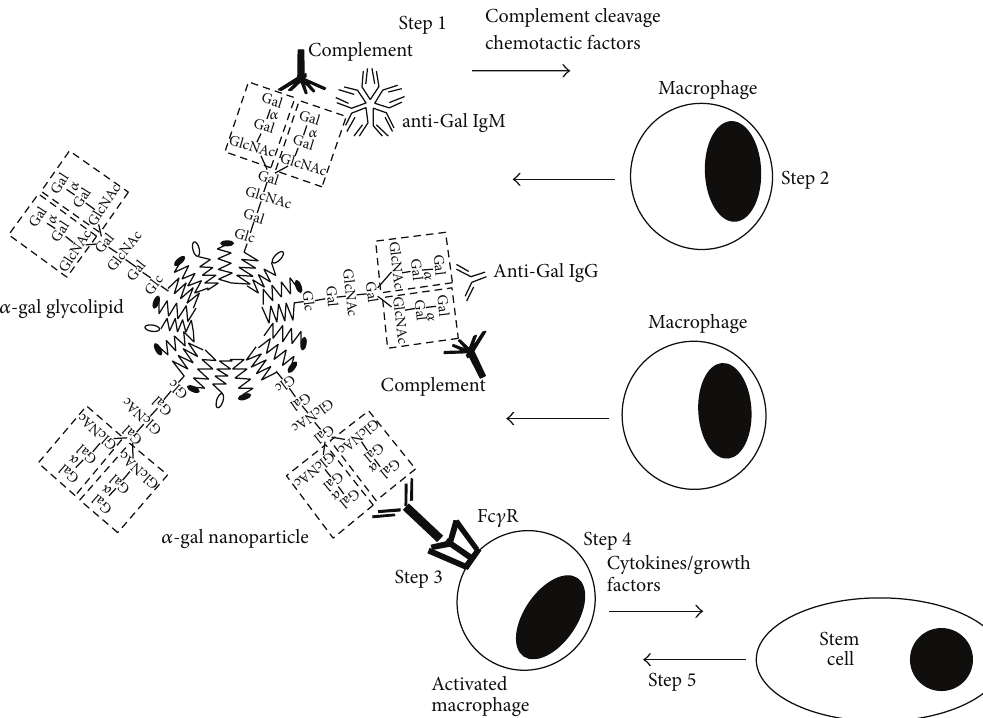
Figure 1: Illustration of 𝛼 -gal nanoparticle and the process of accelerated wound healing induced by these nanoparticles. The studied 𝛼 -gal nanoparticles are comprised of phospholipids, cholesterol, and 𝛼 -gal glycolipids that carry 𝛼 -gal epitopes (a representative 10 carbohydrate glycolipid with two branches, each capped with an 𝛼 -gal epitope, marked by a dashed line rectangle). Application of 𝛼 -gal nanoparticles to injuries results in the induction of the following sequential steps. (1) The natural anti-Gal Ab binds to 𝛼 -gal epitopes on the nanoparticles and activates the complement system, resulting in formation of complement cleavage chemotactic peptides. (2) The chemotactic complement peptides induce rapid and extensive recruitment of macrophages into the treated injury. (3) The 𝛼 -gal nanoparticles activate the recruited macrophages as a result of interaction between the Fc portion of anti-Gal coating the nanoparticles and Fc 𝛾 receptors (Fc 𝛾 R) on macrophages. (4) The activated macrophages produce “prohealing” cytokines/growth factors. (5) Secreted cytokines/growth factors further mediate rapid recruitment of stem cells into the injury site. Modified from